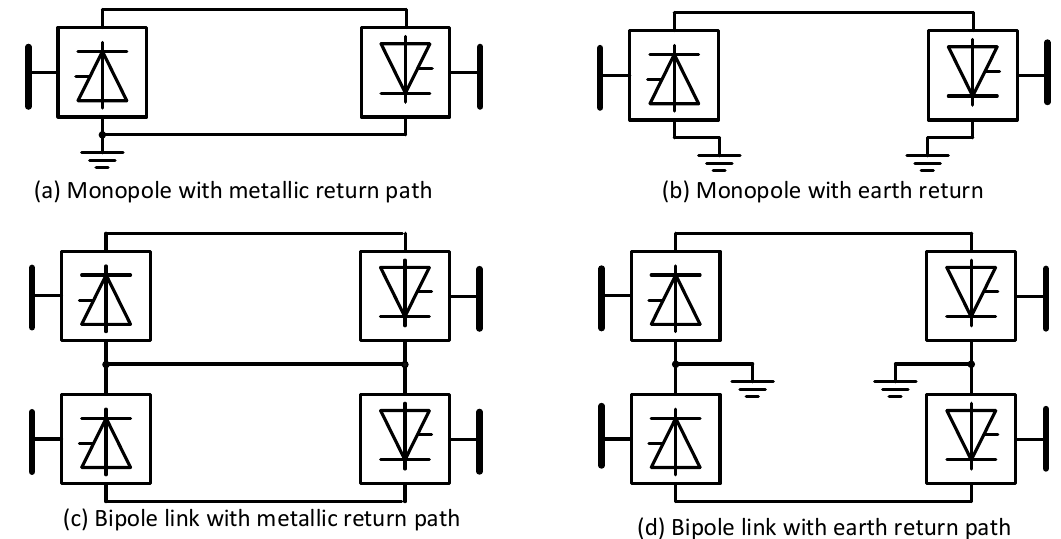
Figure 8. Arrangements of High Voltage Direct Current (HVDC) poles: ( a ) Monopole with metallic return path; ( b ) Monopole with earth return path; ( c ) Bipole with metallic return path; ( d ) Bipole with earth return path.